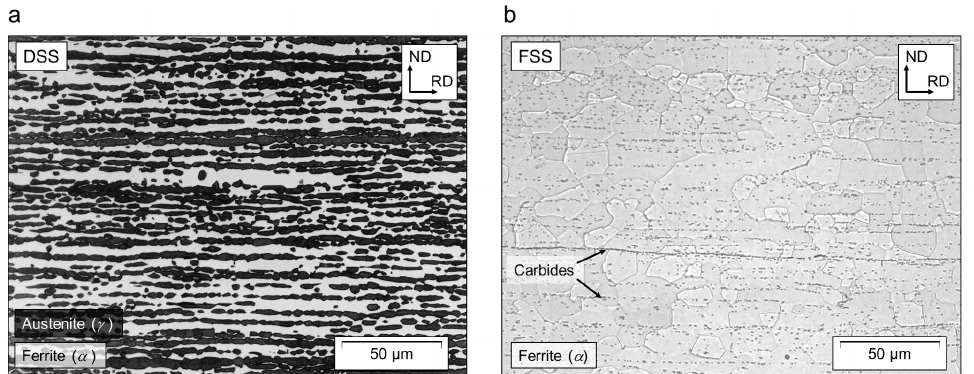
Figure 2. Micrographs of longitudinal sections of duplex stainless steel 1.4362 ( a ) and ferritic stainless steel 1.4016 ( b ), determined by light optical microscopy after etching with Lichtenegger–Bloech and V2A etchant, respectively; rolling direction (RD) and normal direction (ND) are indicated.